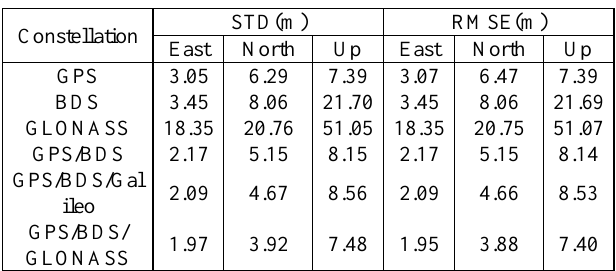
Table 5 . Statistical results of smartphone static positioning